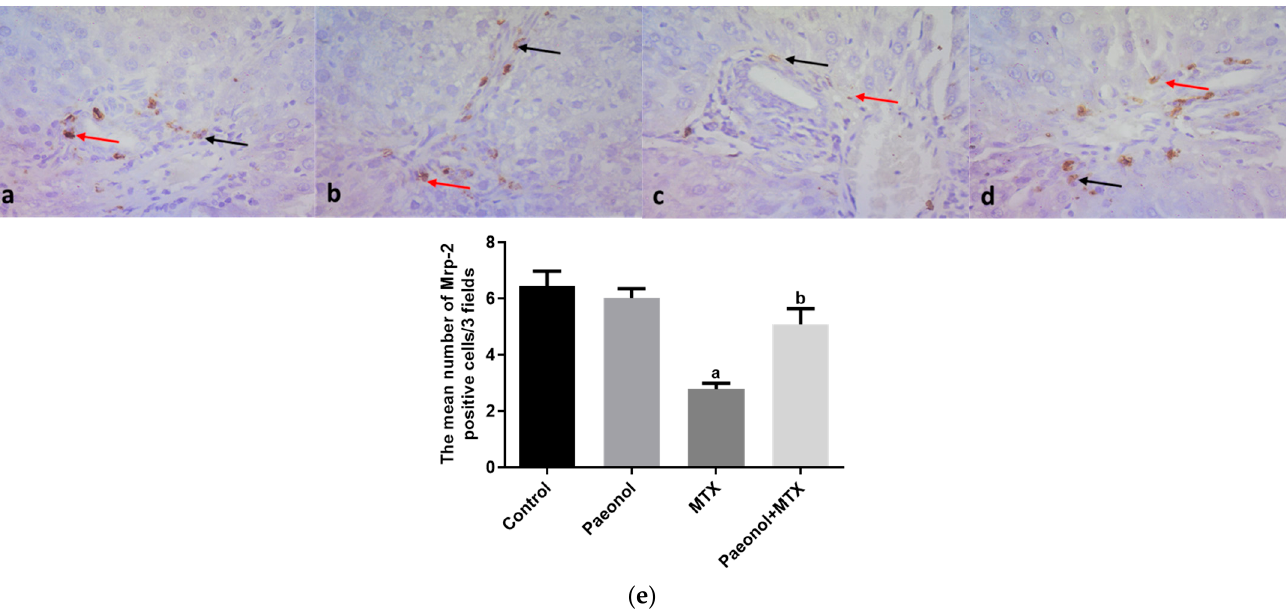
Figure 8. The immunohistochemical examination of hepatic multidrug resistance-associated protein 2 (Mrp-2) expression in methotrexate (MTX)-induced hepatotoxicity ( × 400). The liver tissues of the control ( a ) and paeonol ( b ) groups show cytoplasmic (black arrows) and nuclear (red arrows) Mrp-2 expression in the portal tract cells, mainly in the cells of bile ductules. The liver tissues of the MTX-treated rats show little cytoplasmic (black arrow) and nuclear (red arrow) Mrp-2 expression in the previously mentioned cells ( c ). In contrast, the liver tissues of the paeonol + MTX group show marked cytoplasmic (black arrow) and nuclear (red arrow) Mrp-2 expression in the portal tract cells, mainly in the cells of bile ductules ( d ). A semi-quantitative analysis of Mrp-2 positive cells ( e ). Data are represented as mean ± SEM ( n = 6). Letters a,b Denote significant differences from the normal control and the MTX groups, respectively, at p ˂ 0.05.